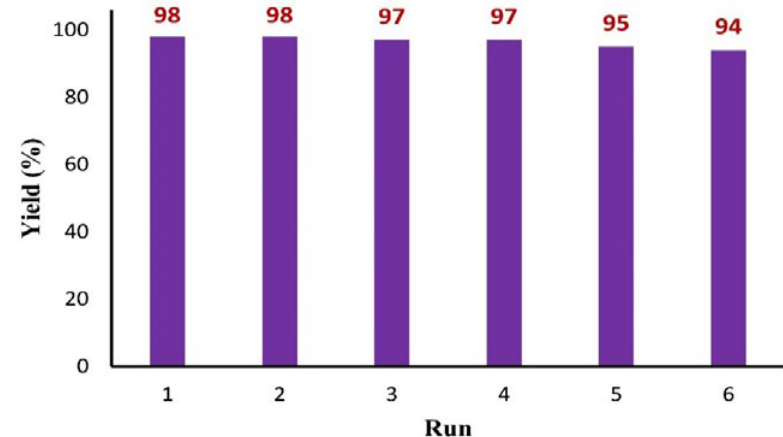
Fig. 7. Relation curve between ln (C Figure 7 . Relation curve between ln (C 0 /C t ) and time (t).